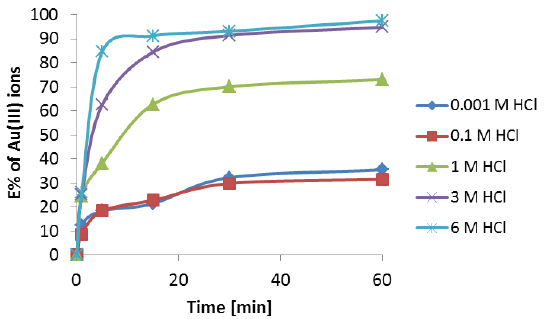
Figure 4. Influence of hydrochloric acid concentration and phase contact time on the extraction of Au(III) ions (100 µ g · cm − 3 ). The phases were composed of the 25 cm 3 aqueous phase in contact with the 25 cm 3 organic phase (5% v / v Cyanex 272 in toluene). Extraction of gold(III) was dependent on the HCl concentration. Extraction of gold(III) ions was the most effective in the range of 3 – 6 M HCl concentration, with the E % being approximately 90%. In 1 M HCl, E% was 70%. The least effective conditions were in the 0.001 to 0.1 M HCl concentration range, with E% values of approximately 30%. The